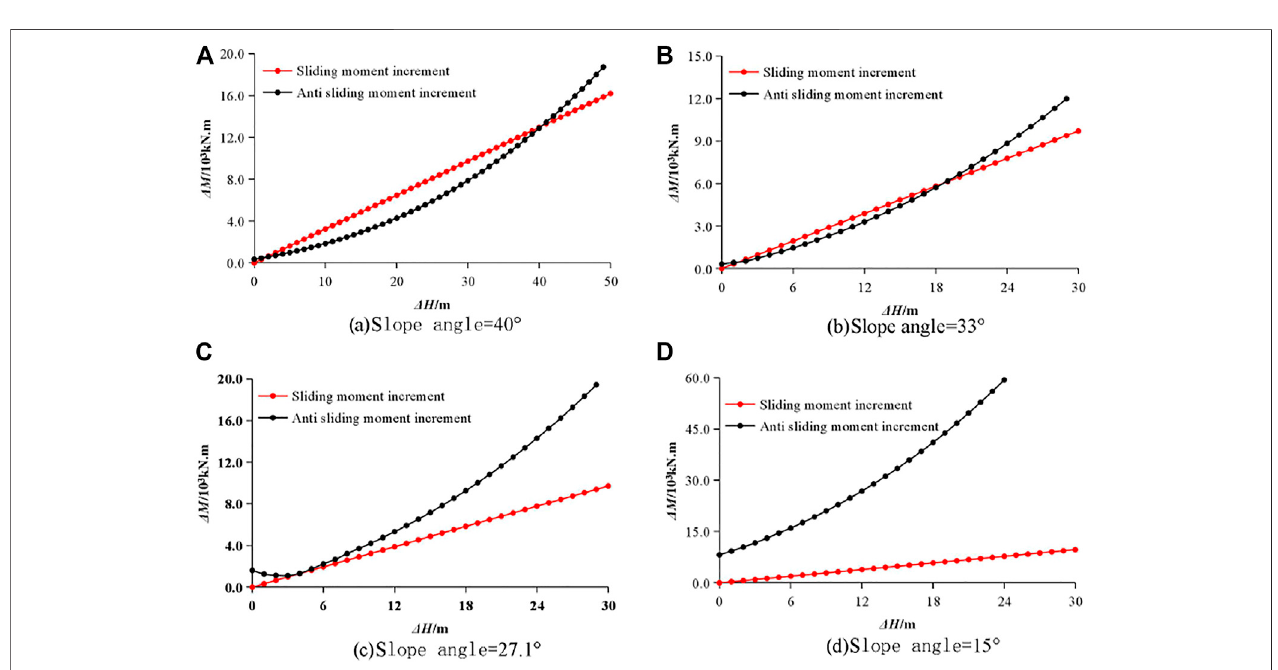
FIGURE 8 | The maximum pile height of the dump at different slope angles. (A) Slope angle = 40 ° , (B) slope angle = 33 ° , (C) slope angle = 27.1 ° , (D) slope angle = 15 ° .